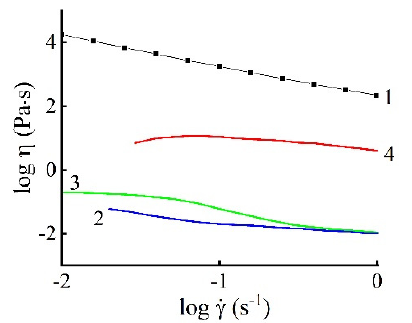
Figure 7. Flow curves of 1% wt. aqueous suspension of various particular celluloses: BC of this study—1, cellulose whiskers—2 [40], NCC—3 [38] and mixture of MCC and Na-carboxymethylcellulose—4